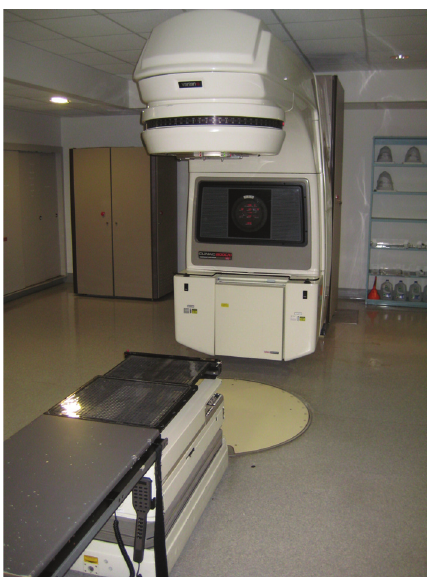
Figure 1: The linear